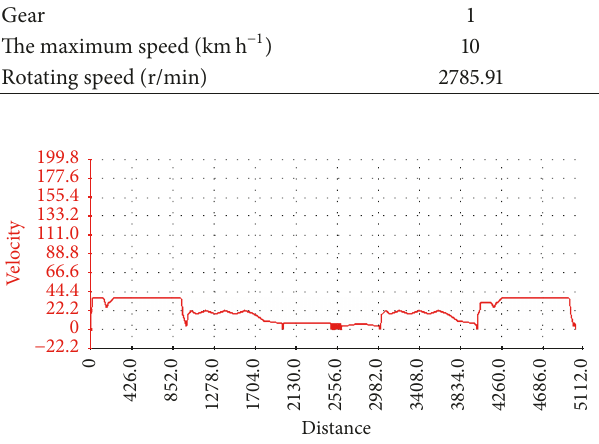
Figure 2: Operating condition.